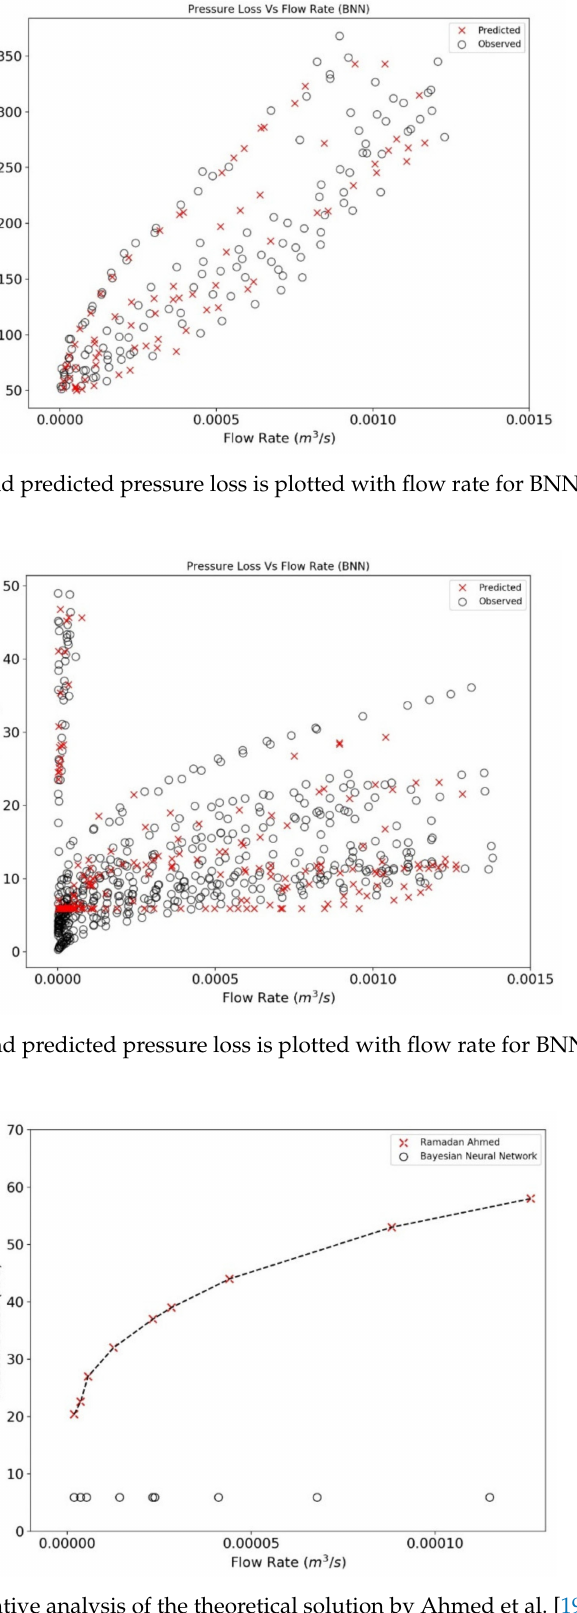
Figure 17. Comparative analysis of the theoretical solution by Ahmed et al. [19] and the